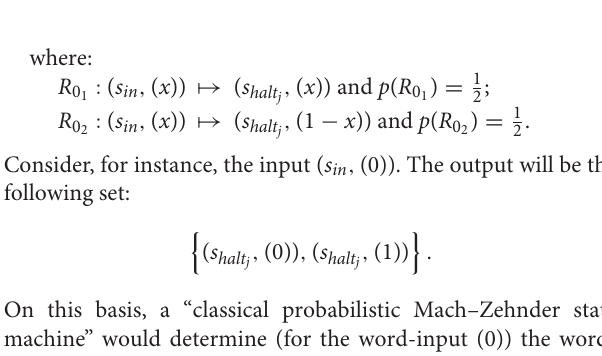
FIGURE 3 | The quantum skier.